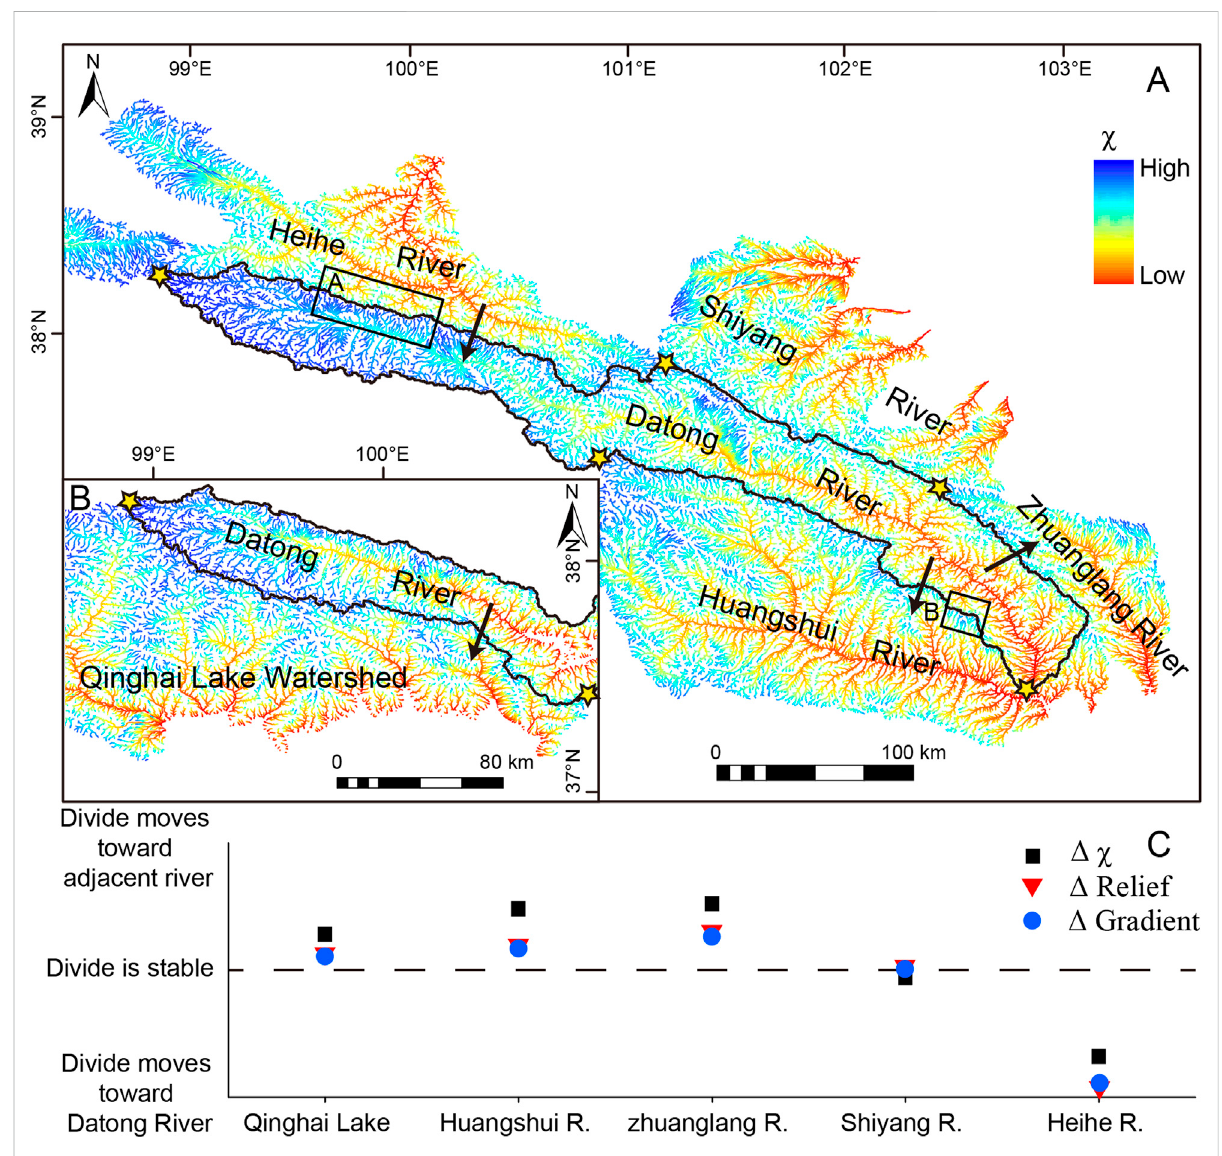
FIGURE 3 (A – B) : χ -maps of the Datong River basin and adjacent drainage basins. The black line indicates the divide, and the yellow stars are the boundaries between the divide segments. Black arrows indicate the predicted divide migration directions. (C) : Standardized delta plot for the fi ve segments along the divide of the Datong